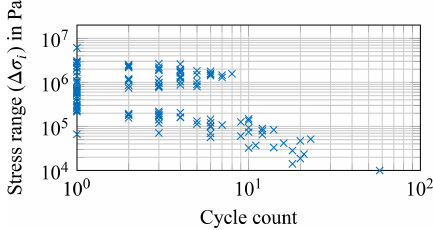
Figure 11. Results of the rain flow cycle count for a 10min inter- val (18 March 2016; 00:10:00). Strain gauge at 225 ◦ , which corre- sponds to side-to-side direction for this